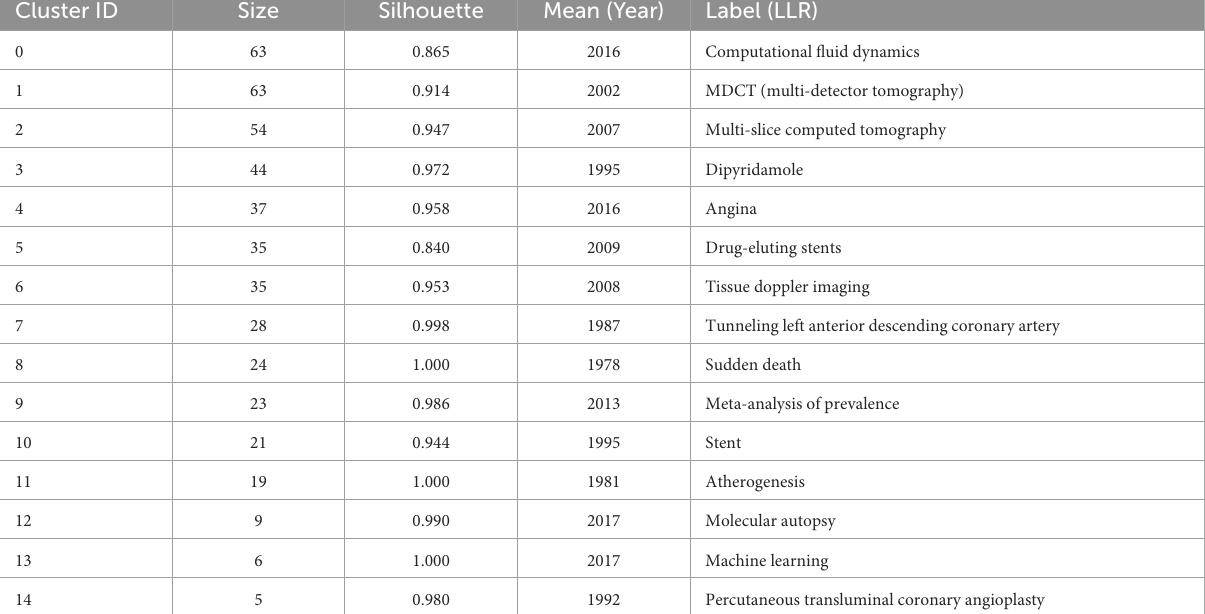
TABLE 6 Details of